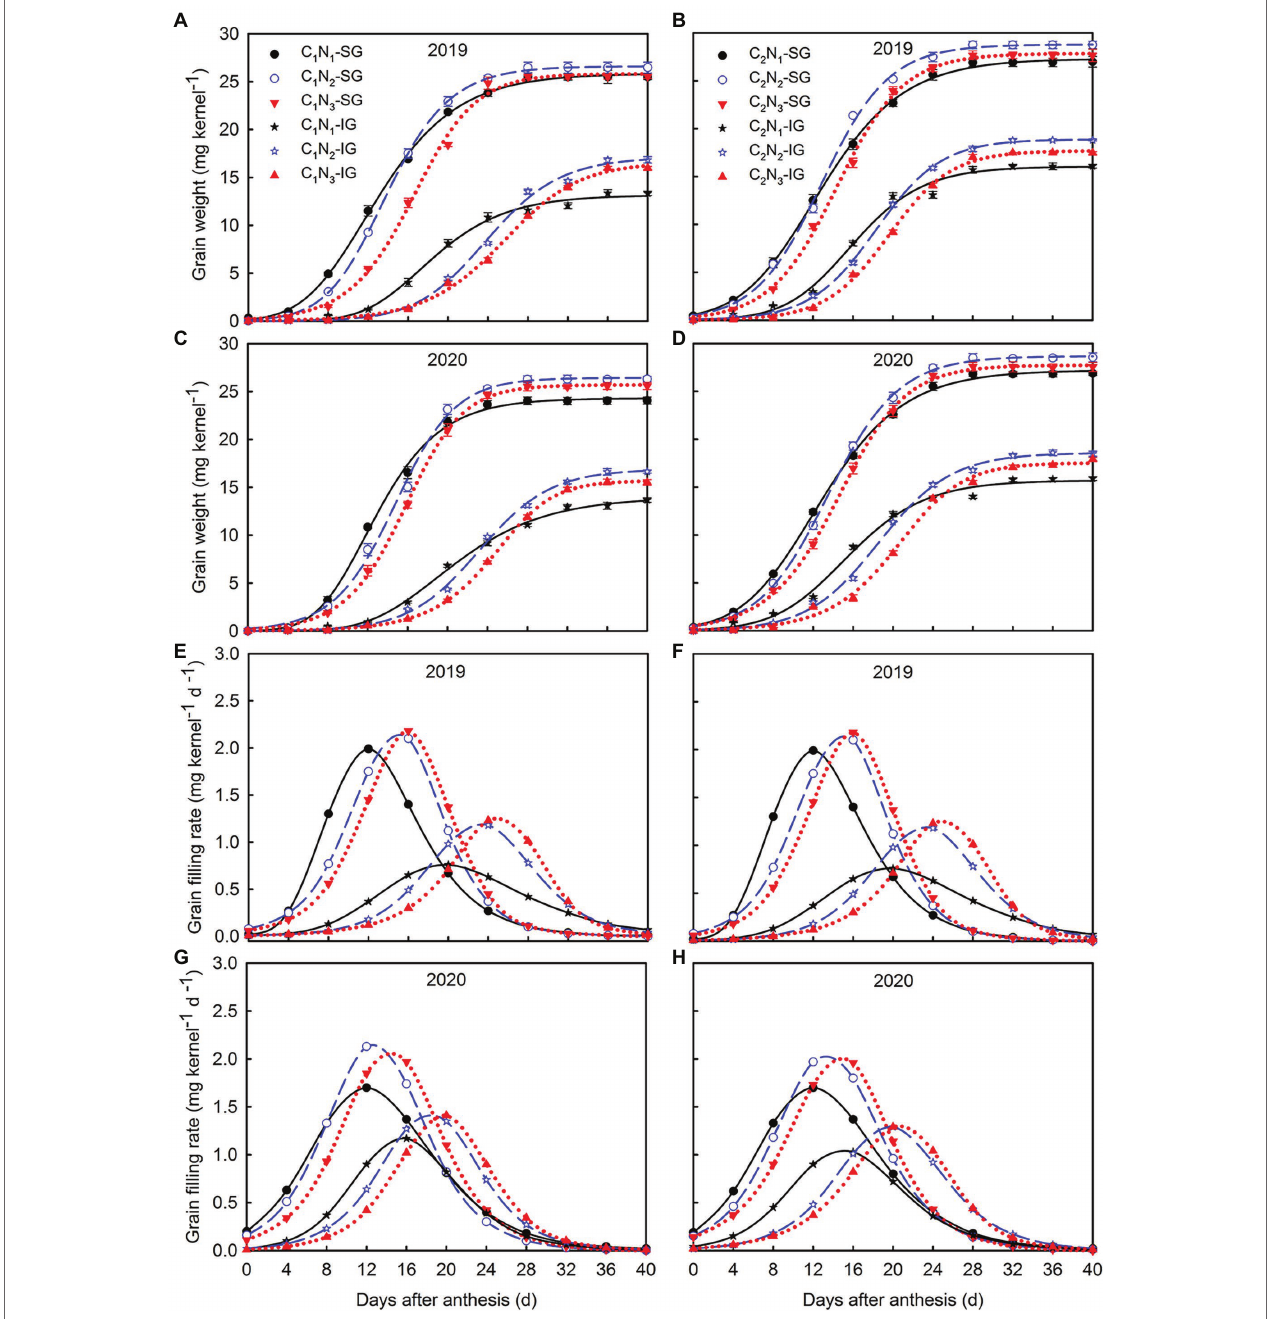
FIGURE 6 | Changes of weight grain (A–D) and filling rate (E–H) of superior and inferior grains under different N application rates. Data are mean ± SE ( n = 3). SG: superior grain; IG: inferior grain; C 1 : Chuannongyou 508; C 2 : Shuangyou 573; N 1 : 75 kg ha − 1 ; N 2 : 150 kg ha − 1 ; N 3 : 225 kg ha − 1